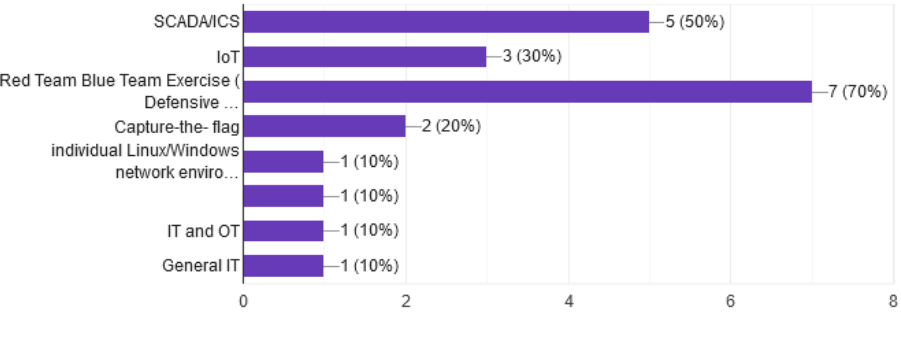
Figure 3. Domains of the Cyber